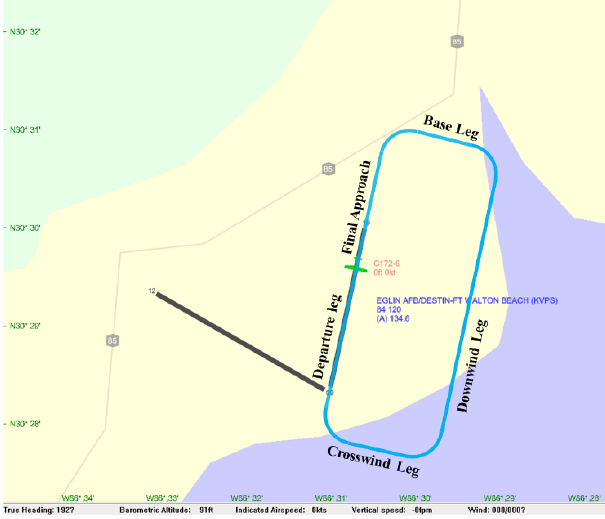
Figure 4. Schematic diagram of airfield traffic pattern.